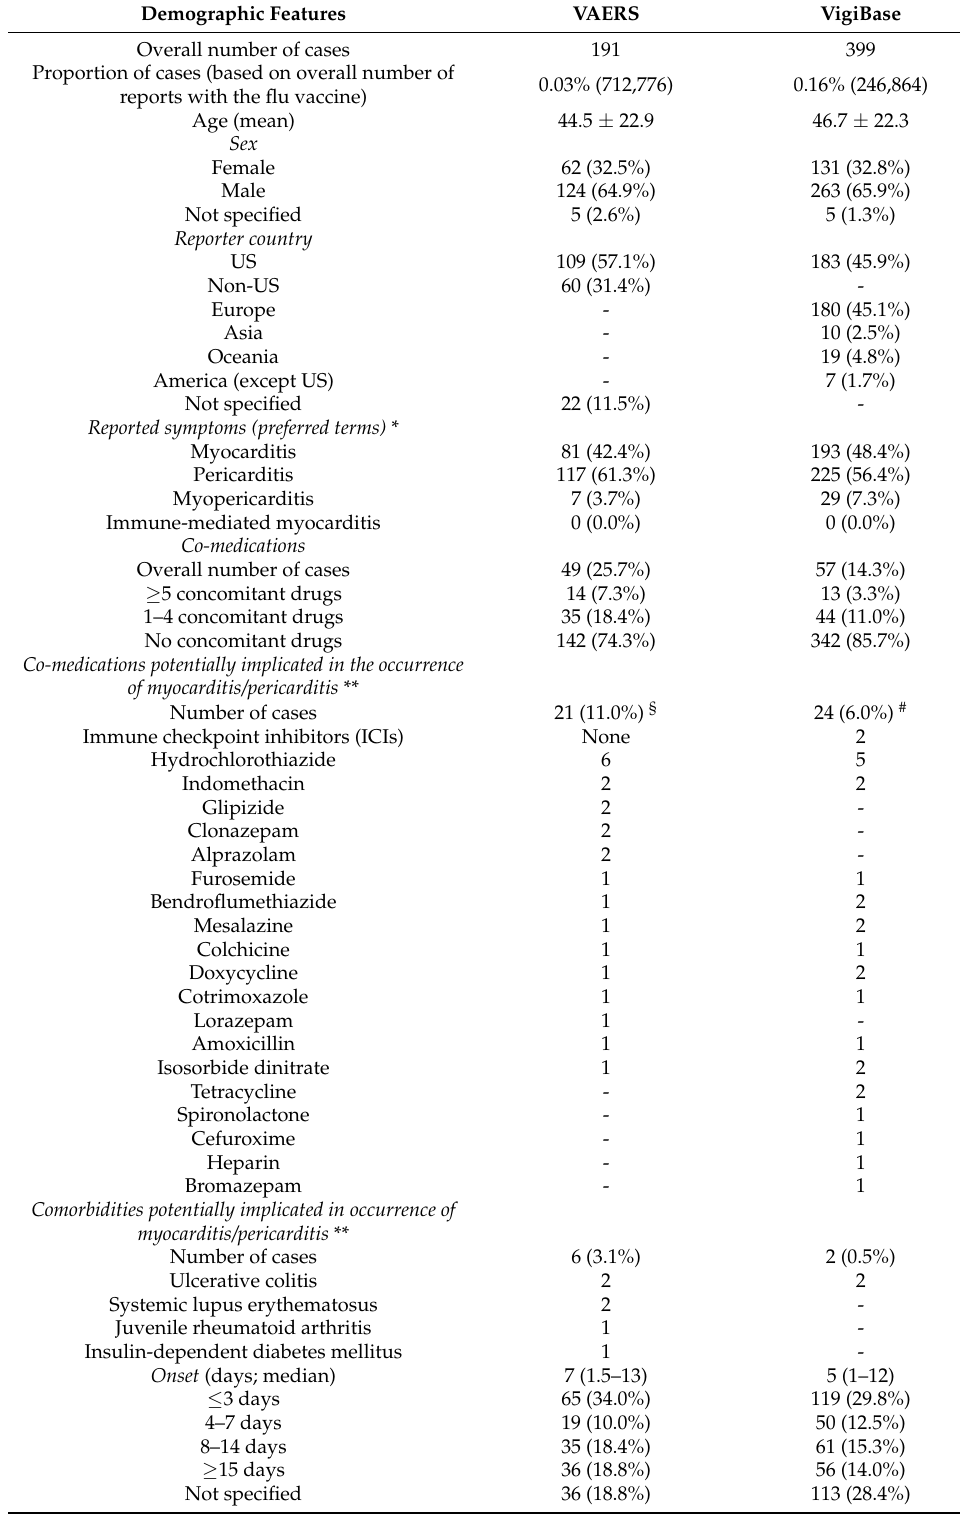
Table 1. Demographic and clinical feature of cases of myocarditis/pericarditis reported with influenza vaccine as suspect in Vaccine Adverse Event Reporting System (VAERS) and the World Health Organization’s (WHO) global Individual Case Safety Report database (VigiBase ®